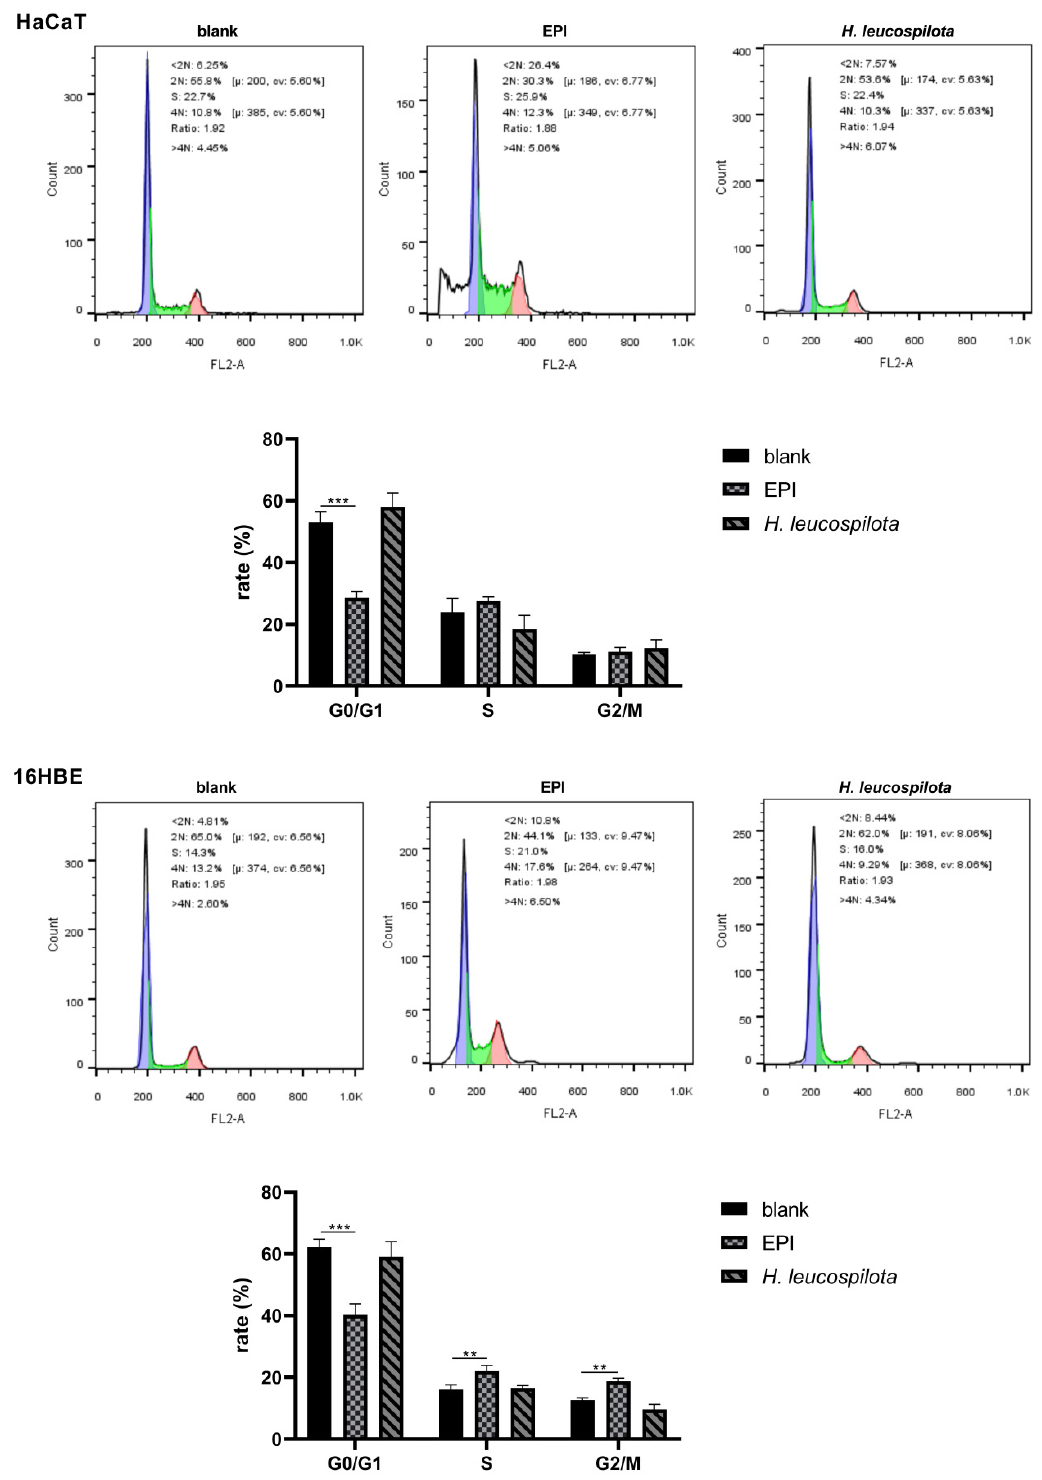
Figure 2. Effect of H. leucospilota protein on cell cycle distribution. Cells were treated with the IC 50 concentrations of H. leucospilota protein for 48 h, with EPI (10 µ M) as positive control. All experiments were repeated at least three times. Data are mean ± SD. * p < 0.05, ** p < 0.01, *** p < 0.001, **** p < 0.0001.